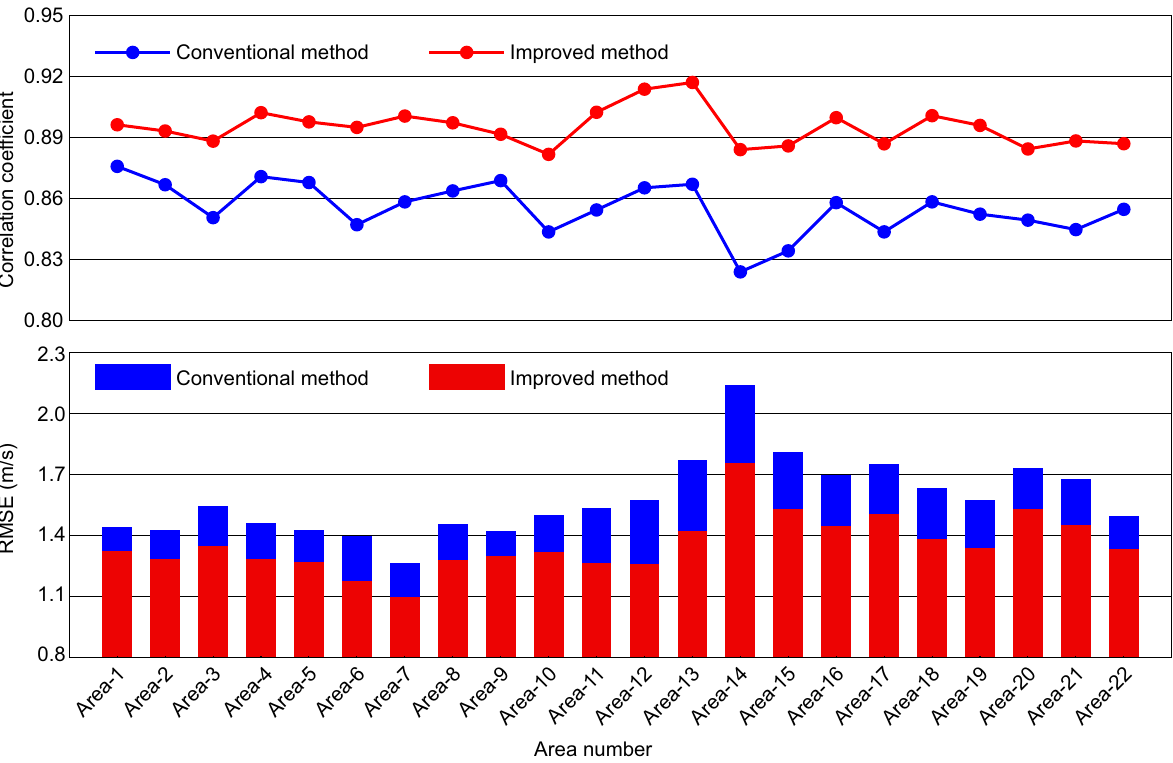
Fig. 11 The retrieval performance comparison between the conventional method and the improved method for each